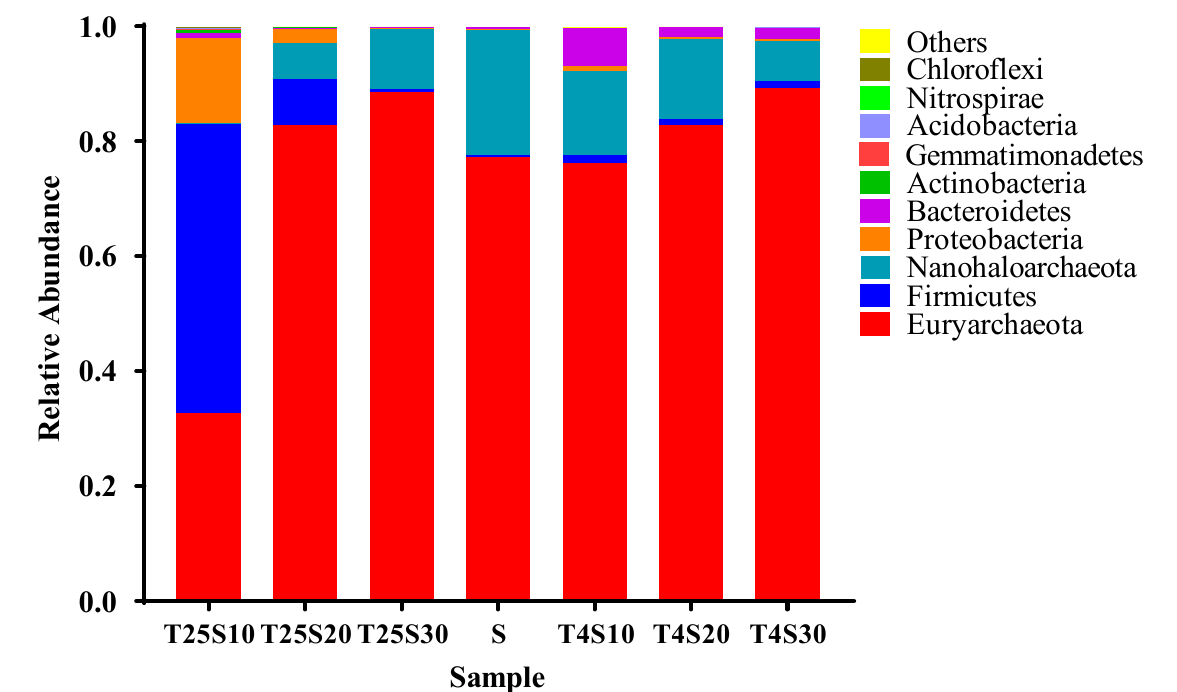
Figure 4. The relative abundance of the top 10 microorganisms at the phylum level in different treatment salted kelp samples .